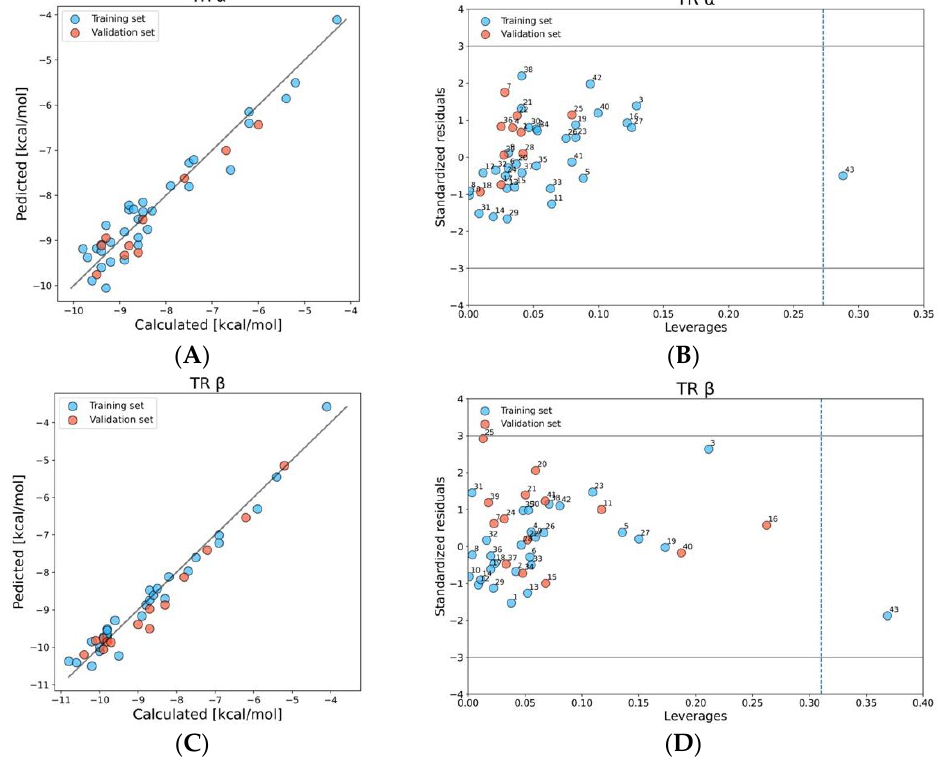
Figure 3. Plot of calculated versus predicted values of binding scores TR α, and β ( A ), ( C ). Williams plot: dash line indicates the critical leverage value, solid lines represent ±3 standard deviation units. ( B ), ( D ).